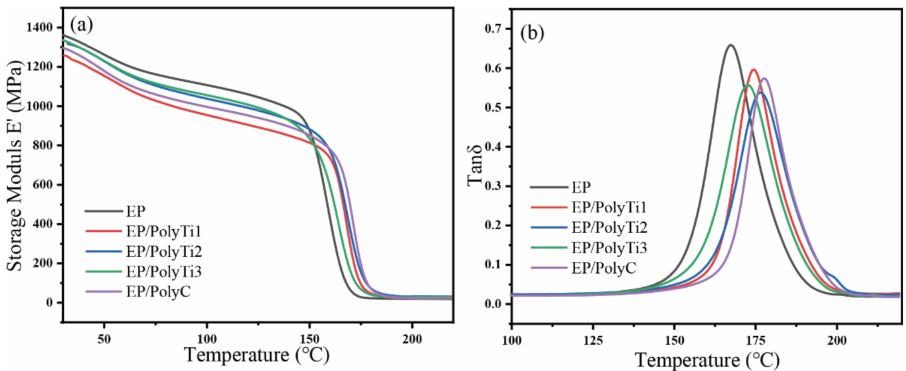
Figure 15. DMA curves of the EP composites: ( a ) Storage Moduls E (cid:48) and ( b ) Tan δ .